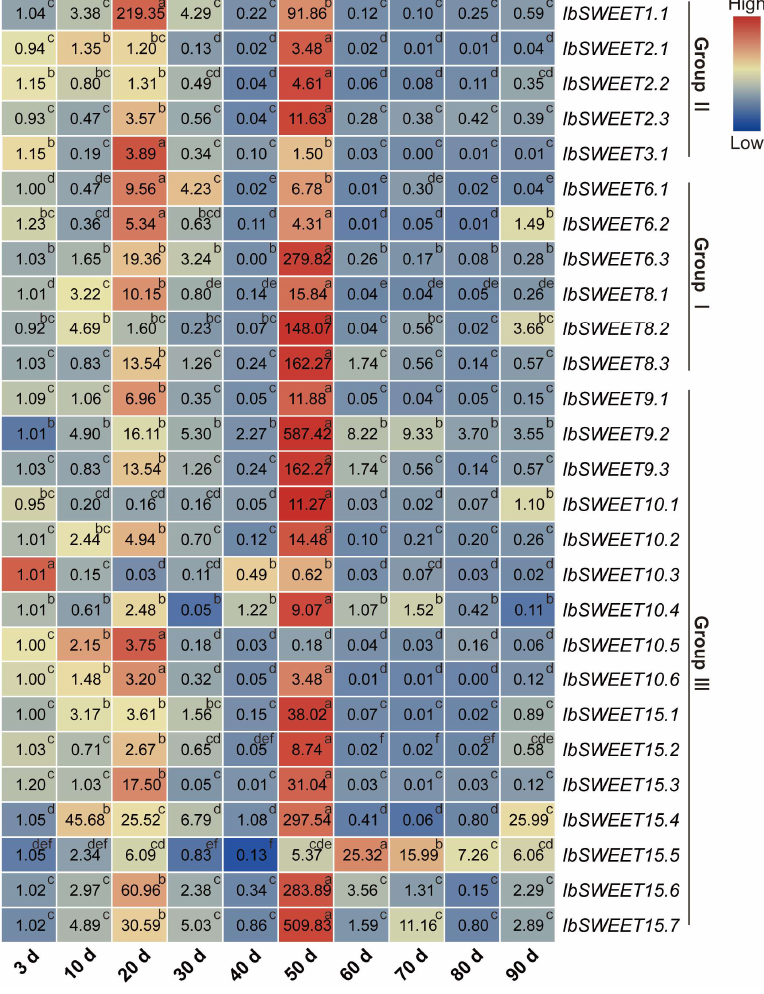
Figure 8. Gene expression patterns of IbSWEETs in different root developmental stages (i.e., at 3 d, 10 d, 20 d, 30 d, 40 d, 50 d, 60 d, 70 d, 80 d, and 90 d) as determined by qRT-PCR. The values were determined by qRT-PCR from three biological replicates consisting of pools of three plants, and the results (i.e., at 3 d, 10 d, 20 d, 30 d, 40 d, 50 d, 60 d, 70 d, 80 d, and 90 d) were analyzed using the